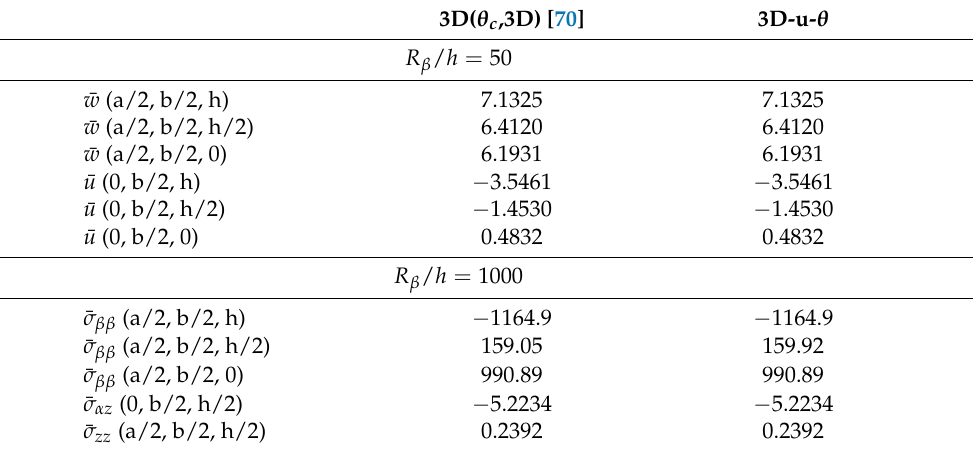
Table 2. Second preliminary assessment, one-layered FGM ( p = 2) cylindrical shell with external sovra-temperature amplitudes Θ t = + 1 K and Θ b = 0 K for m = n = 1. Reference solution is the 3D uncoupled thermoelastic model by Brischetto and Torre [70] with the temperature profile calculated using the 3D Fourier heat conduction Equation (3D( θ c ,3D)). The new 3D coupled thermoelastic solution is 3D-u- θ